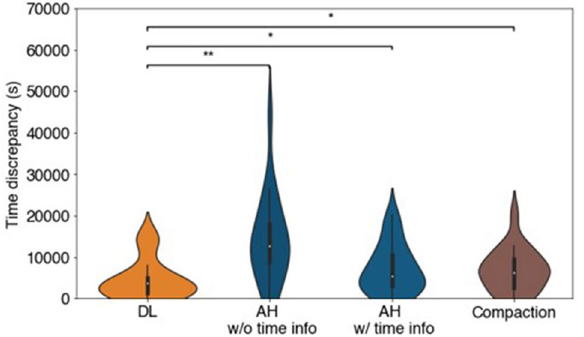
Figure 6. Comparative analysis of the polarity onset time point prediction by the ensemble deep learning model, the average human and the compaction proxy. Violin plot of time discrepancy between the annotated and the predicted polarity onset time index of 19 testing embryos by ensemble DL model, average human (AH) without/with time information and compaction proxy. AH without (w/o) time information (info) means that six human volunteers were given the randomized testing frames without any time information. Their predicted labels were then chronologically ordered for each testing embryo and temporally smoothened in the same manner as the ensemble DL model predictions. The mean discrepancy was taken from the six volunteers. AH with (w/) time information indicates that six human volunteers were given the chronologically ordered frames for each testing embryo. They directly estimated the polarity onset time point from these time sequences. Statistical analysis uses the ensemble DL model result as the reference to test their difference significance and the p -values are specified in the figure for * p < 0.05, ** p < 0.01, *** p < 0.001, **** p < 0.0001, NS not significant, two- sided Wilcoxon matched-pairs signed-rank